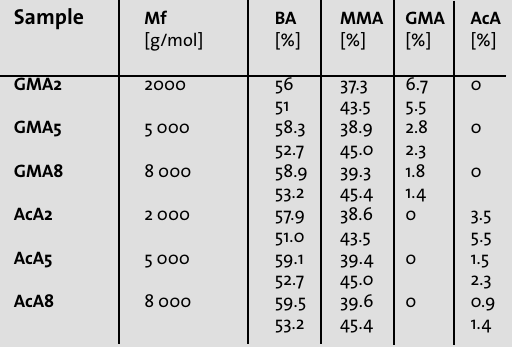
Table 1: Composition of ter- polymers forming the blend components: weight (and molar) fractions of